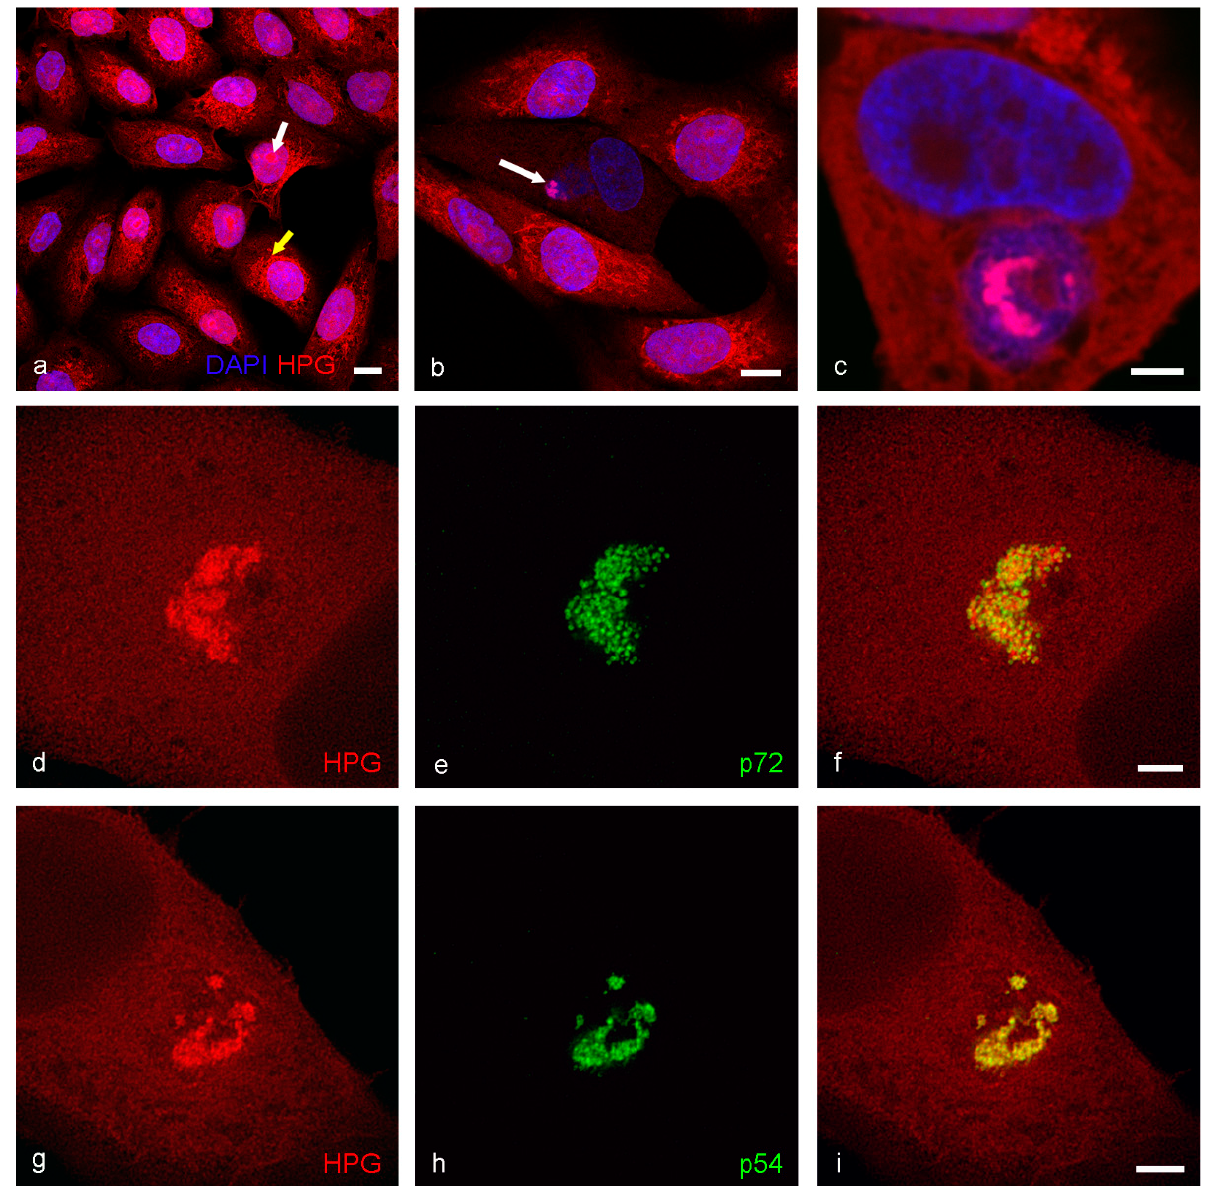
Figure 3. Incorporation of HPG into proteins in Vero cells. Cells were incubated with HPG for thirty minutes after forty-five minutes starvation in methionine free media, then fixed. Cells were subject to Click-IT reaction with azide conjugated to Alexa 555. Confocal image of uninfected ( a ) and 16 hpi ( b , c ) cells show an accumulation of nascent protein in cellular organelles ( a , yellow arrow) and nucleoli ( a , white arrow) and in the viral factory in infected cells ( b , white arrow and c ). By STED microscopy ( d – i ), the HPG labelling co-localized with both p72 (17LD3) and p54 (RB7) labelling. Scale bars: a, b = 10 µ m, c, f, i = 3 µ m.